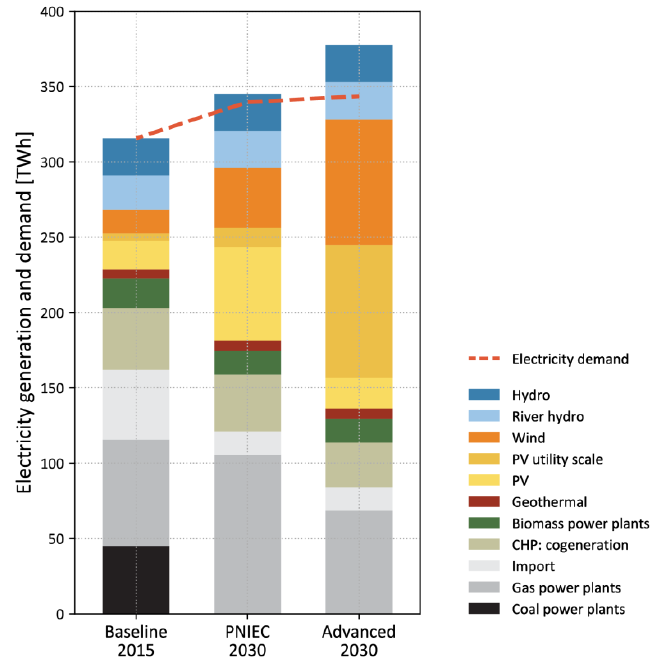
Figure10. AnnualelectricitygenerationforthescenariosBaseline2015, PNIEC2030andAdvanced2030. Figure 10. Annual electricity generation for the scenarios Baseline 2015, PNIEC 2030 and Advanced 2030.